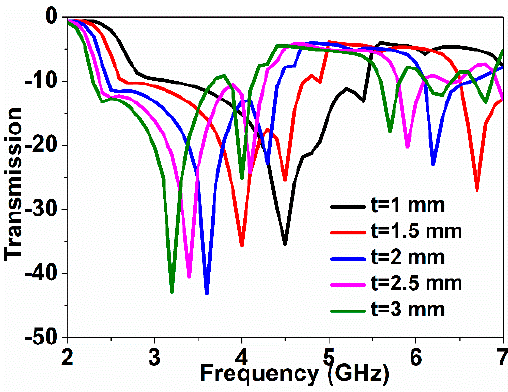
Figure 7. Change in transmission with the change in over-layer thickness.